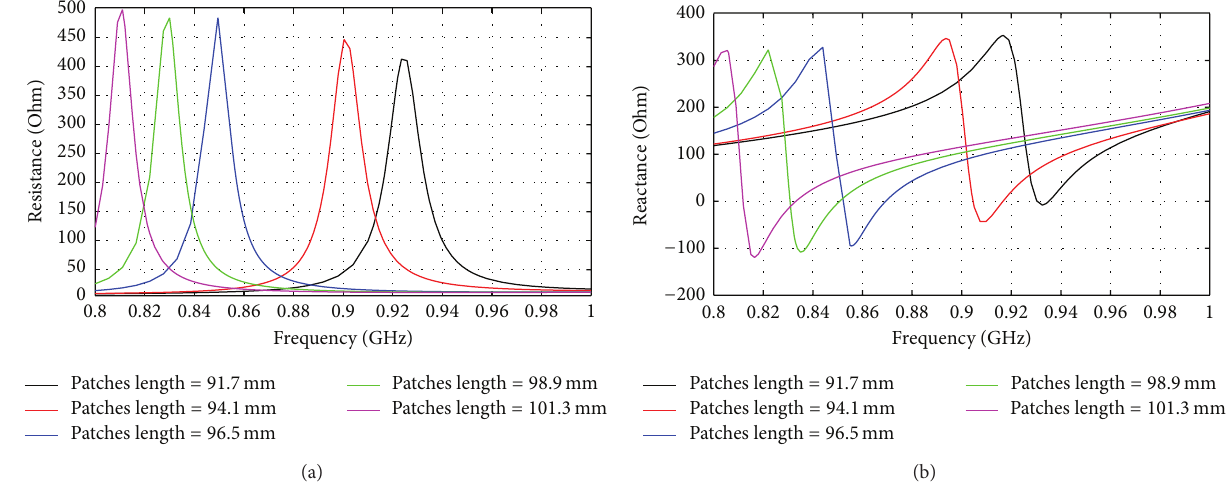
Figure 5: Tuning the real and imaginary parts of the input impedance by varying the patch length.